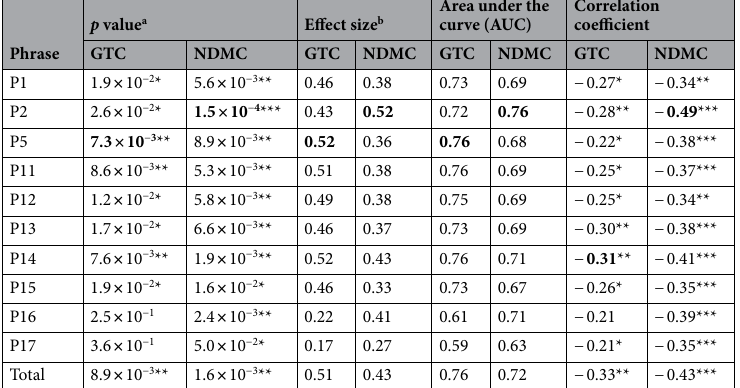
Table 5. A summary of classification performance between no depression and depression groups by the EALVI. The table shows the p values obtained by the Wilcoxon rank sum test, the effect sizes by Cliff’s delta, the AUC, and the correlation coefficient between the HAM-D and EALVI for each phrase of both facilities. The minimum p-value, maximum effect size, maximum AUC, and maximum correlation for each hospital are shown in bold fonts. ***( p < 1.0 × 10 −3 ), **( p < 1.0 × 10 −2 ), *( p < 5.0 × 10 −2 ). a By Wilcoxon rank sum test. b By Cliff’s